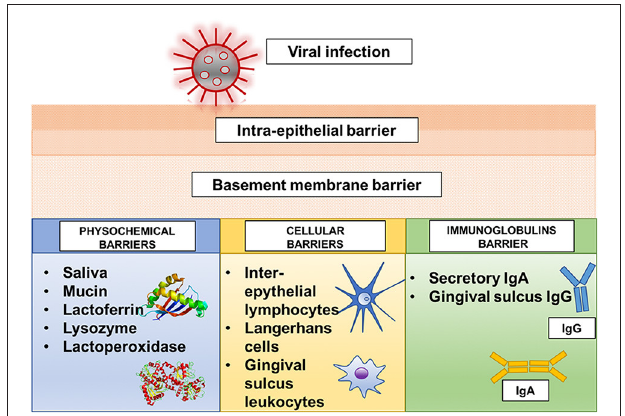
FIGURE 1 | The principal host defense mechanisms in the oral